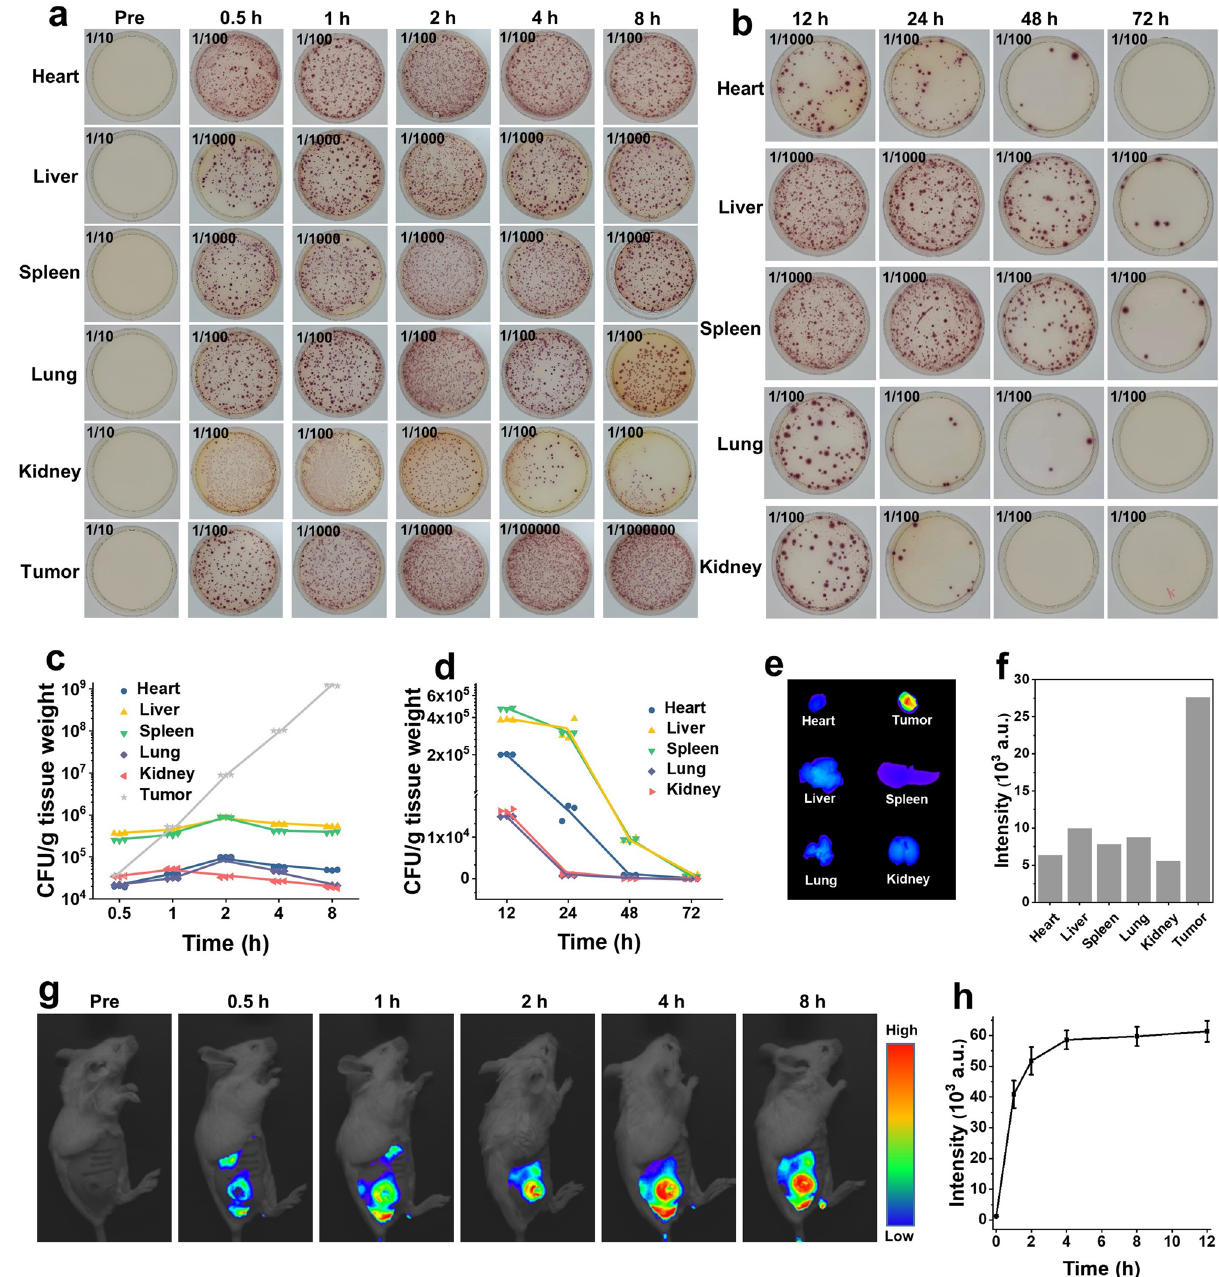
Fig. 2 In vivo distributions of Cu 2 O@ΔSt. a, b Representative photographs of chromogenic Luria–Bertani (LB) agar plates and c, d quantifica- tions of bacterial colonization in different organs collected from a, c CT26-bearing mice or b, d healthy mice at varied time durations after the injections of bacteria ( n = 3, mean ± standard error). e Fluorescence imaging and f corresponding quantifications of fluorescence intensities of main organs and tumors isolated from mice in 8-h post-injection of IR780-labeled Cu 2 O@ΔSt ( n = 3, mean ± standard error). g In vivo fluores- cence images of CT26 tumor-bearing mice and h corresponding fluorescence intensities at the tumor site over time after the injection of IR780 labeled Cu 2